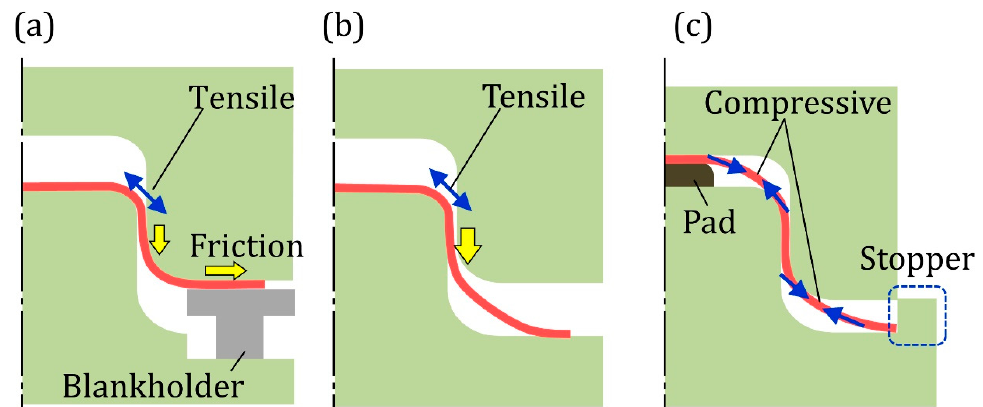
Figure 2. Changes in thickness around corners in hot-stamping processes: ( a ) draw bending, ( b ) crash forming and ( c ) compression bending.